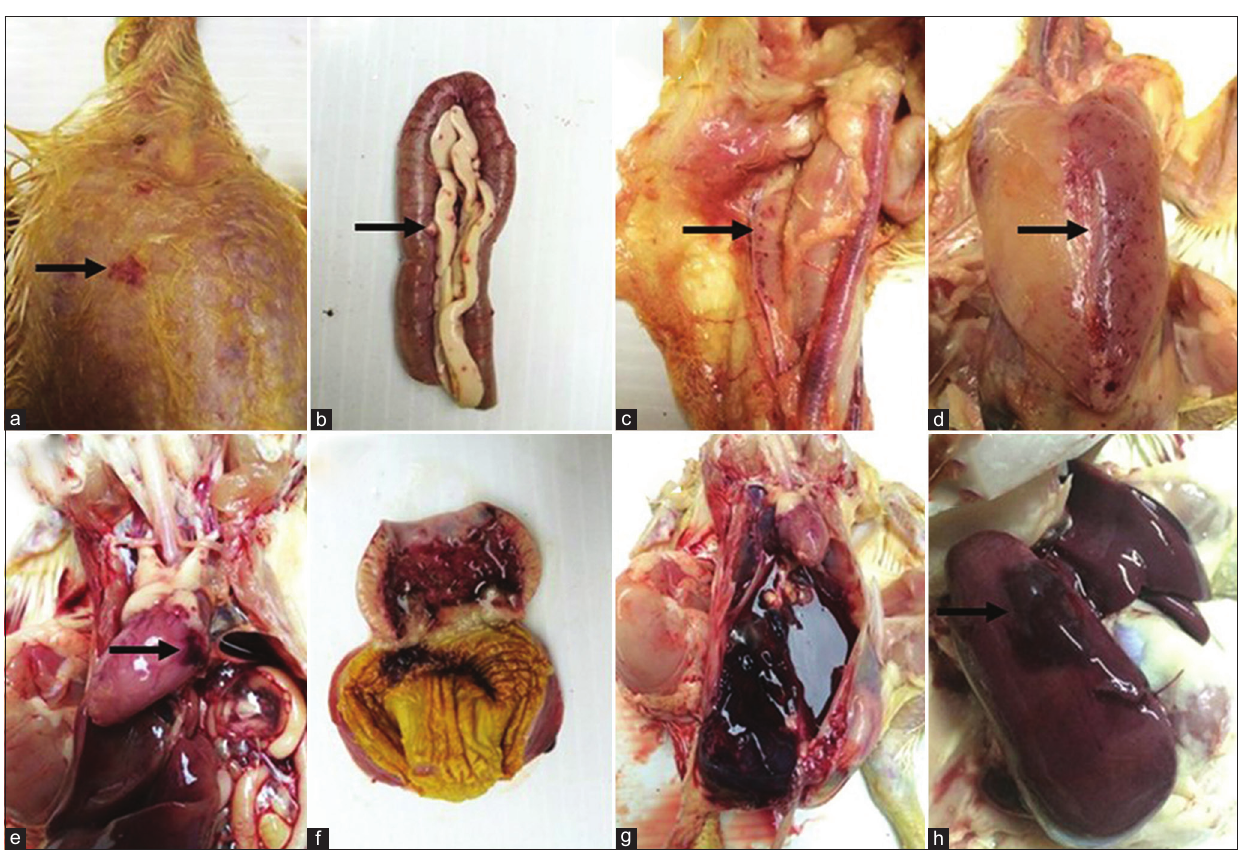
Figure-1: Gross lesions of Leucocytozoon caulleryi infecting backyard chickens. (a) Subcutaneous hemorrhage in pectoral, (b) multifocal hemorrhage and megaloschizont in the pancreas and intestine, (c) thymus, (d) pectoral muscles, (e) petechial hemorrhage in epicardium, (f) hemorrhage in proventriculus and gizzard, (g) hemorrhage in the peritoneal cavity, (h) liver lobe was enlarged and had a subcapsular hemorrhagic region (arrows).